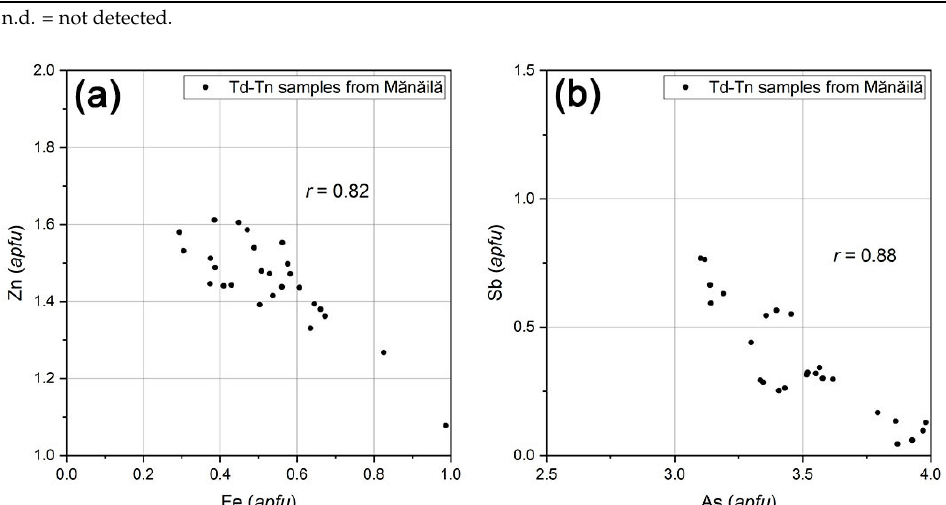
Figure 11. Distribution within the series of tetrahedrite-tennantite from the Mănăilă ore deposit with a correlation between Fe and Zn apfu ( a ); and between As and Sb apfu ( b ). The high As contents correlate with sulfur concentration. Sb appears in lower amounts and its apfu varies between 0.04–0.77. As and Sb occupy the D sites in the ten- nantite structure. In some samples, As and Sb are substituted by Bi, but in most samples, Bi is below the detection limit. Bi occurs mostly in the copper mineralization up to 0.26 afpu . Bi contents in tetrahedrites were also reported by Buzatu et al. [27] in hydrothermal mineralization from Baia Sprie, Eastern Carpathian. In almost all samples, a sulfur deficit is noted because the afpu value is below 13, with some exceptions (Table 7). The average stoichiometric formula of tennantites calculated on the basis of 29 atoms is: (, ) . (, , , , ) . (, , ) . which is close to the ideal for- mula of tennantite [28]. The tennantites formula from Mănăilă is slightly variable (Table 7) because the values of As afpu (3.10–4.15) and Sb afpu (0.04–0.77) are in the same range of variation. It is obvious that the studied tennantites are homogeneous since the ratio Sb/(Sb + As) is close to zero (0.09), with a variation of 0.01–0.20, indicating a pure tennan- tite member. In recent years, several Raman studies on tetrahedrite-tennantite solid solution series have pointed out systematic changes in terms of peak position and changes of relative intensity [25,29]. The fundamental modes (ν 1 to ν 4 ) of As-rich members of the series are clearly observed in the Raman spectra (Figure 12). The most notable spectral feature is represented by the ν 1 mode located at 385 cm −1 which can be assigned to the symmetric stretching of pyramidal groups AsS 3 . The other fundamental modes are displayed as shoulders, as follows: antisymmetric stretching ν 3 at 365 cm −1 ; symmetric bending ν 2 at 342 cm −1 ; and antisymmetric bending ν 4 at 312 cm −1 . The lattice modes are observed in the low wavenumber region of the Raman spectra (below 202 cm −1 ). Considering the previous Raman studies [25,29], the spectral features are in agreement with the chemistry (Tables 6 and 7).